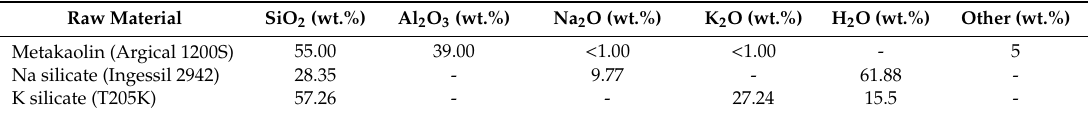
Table 2. Composition of commercial raw materials used to prepare the